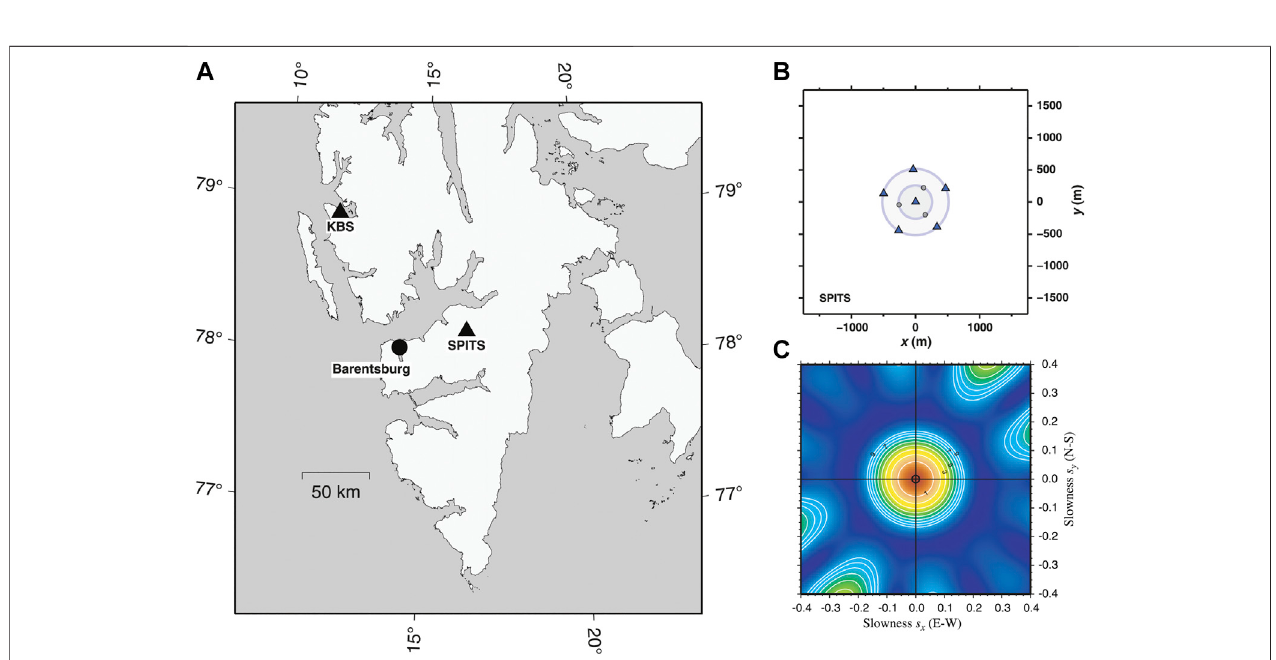
FIGURE 4 | (A) Map showing the location of the small-aperture SPITS array (black triangle) on Spitsbergen; (B) station locations showing the nine-station array design with approximate 1 km aperture, with three-component stations shown by triangles and single component stations by circles; and (C) the associated array response as a function of the horizontal slowness evaluated at 4 Hz. Map and fi gures taken from Gibbons (2006) and Gibbons et al. (2011).